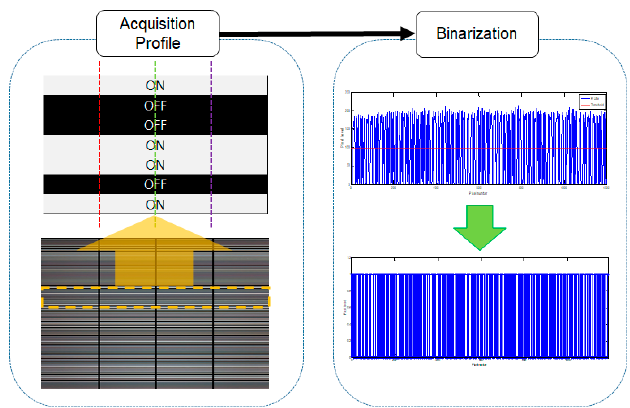
Figure 4. Pulse profile acquisition and binarization.